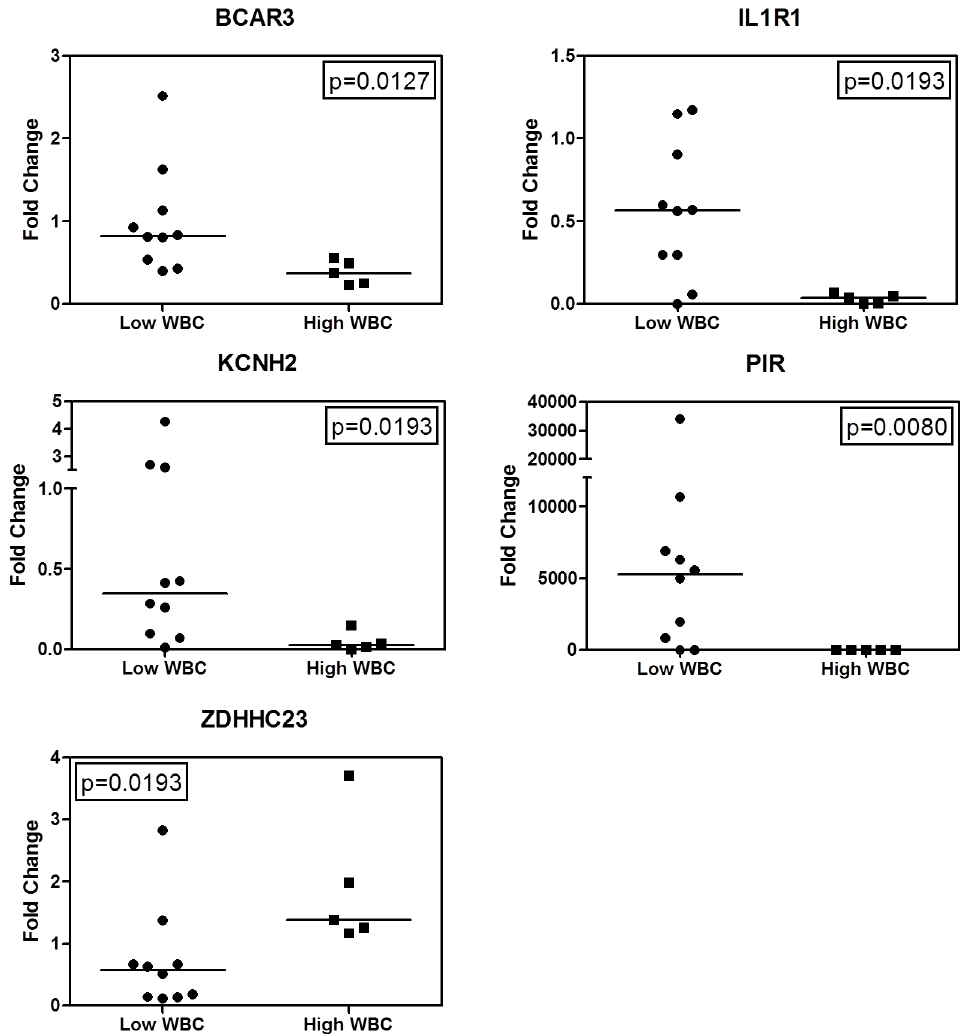
Fig 2. BCAR3 , IL1R1 , KCNH2 , PIR , and ZDHHC23 expression levels were significantly different between low and high WBC ETV6-RUNX1 -positive patient samples. Total RNAs from ETV6-RUNX1 - positive patient samples were isolated. cDNA was prepared using 1 μ g total RNA and transcript levels were determined by real-time RT-PCR. Transcript levels were normalized to RPL13a and relative expression levels were calculated using the comparative Ct method (comparing all samples to the expression levels in the ETV6-RUNX1 -positive REH cell line). The horizontal lines indicate the median. The P -values were calculated using the Mann-Whitney U -test and GraphPad Prism 5.0